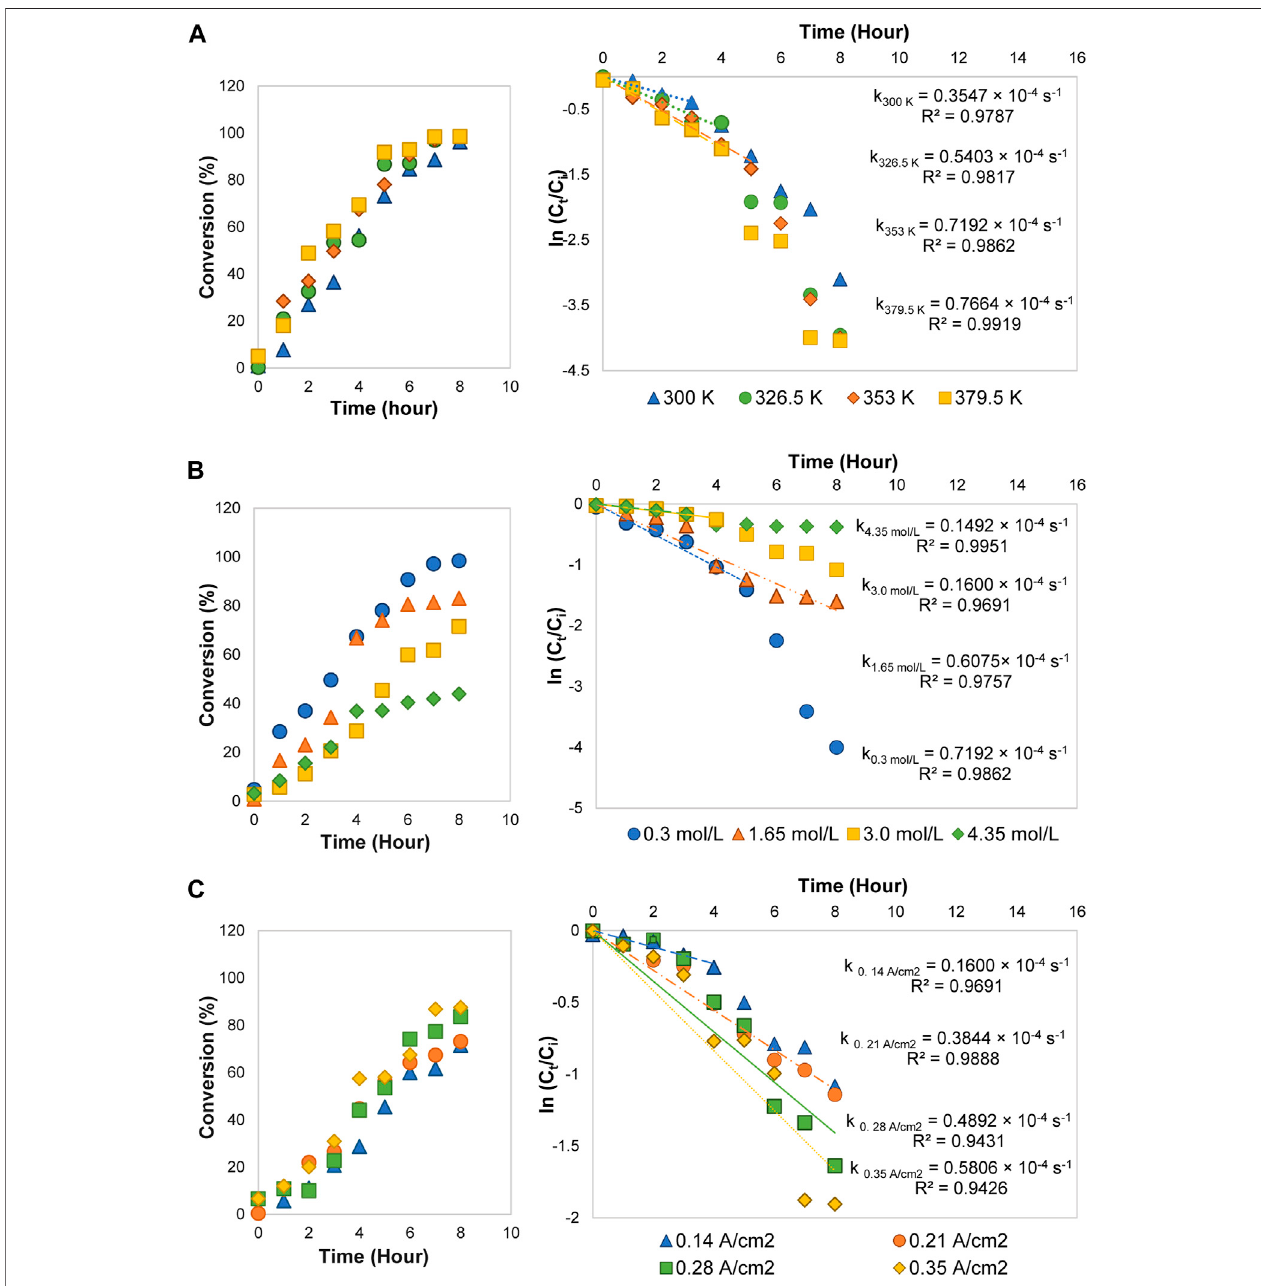
FIGURE2| Conversionsand fi rst-orderkineticsmodelsofacetolelectrocatalytic reductionatdifferent (A) reaction temperatures, (B) initialconcentrations,and (C) current densities.